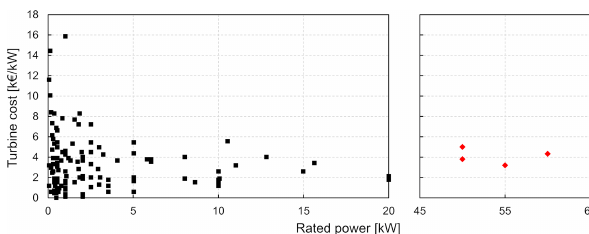
Figure 5. Turbine purchase cost survey for rated power lower than 20kW (Kaldellis and Zafirakis, 2012) and around 50kW (authors’